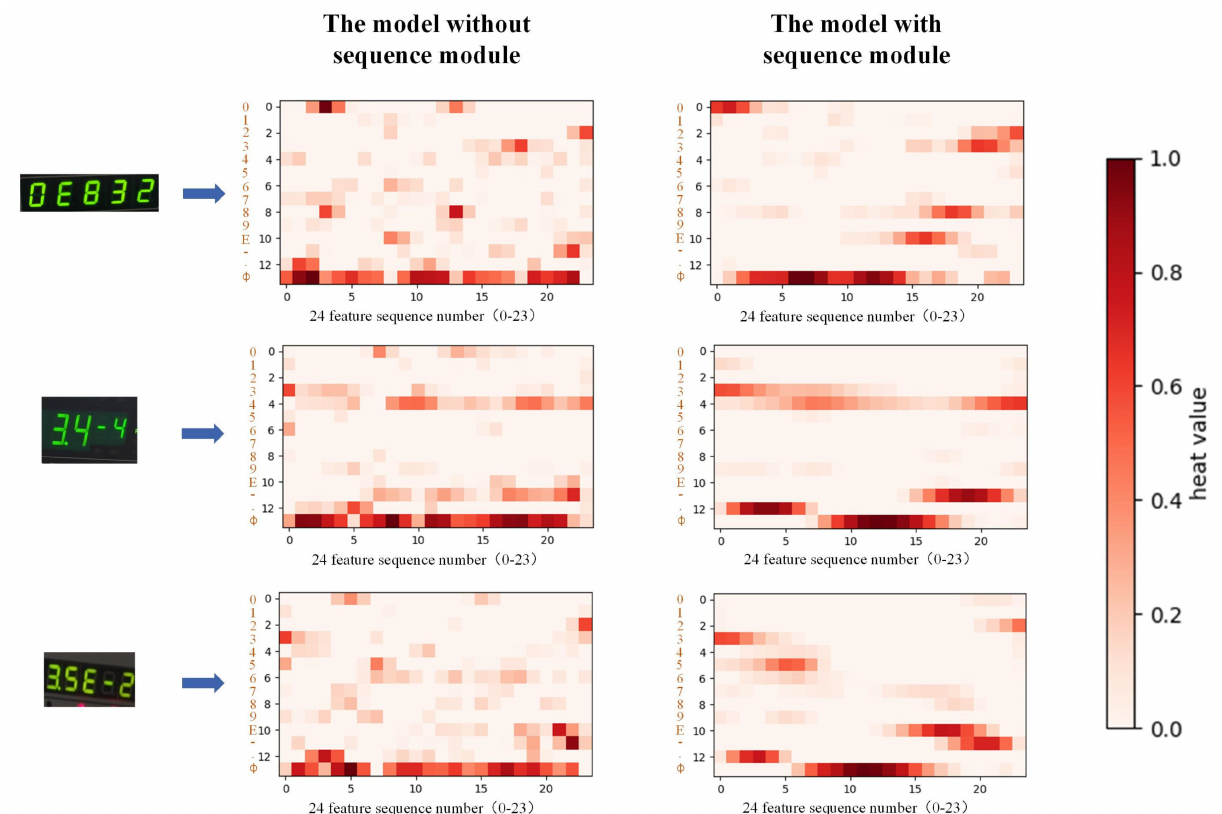
Figure 9. Heat map of the feature sequence output from sequence module or not. Left shows the heat map of the feature sequence directly output from the feature extractor without sequence module, and right shows the feature sequence output from the sequence